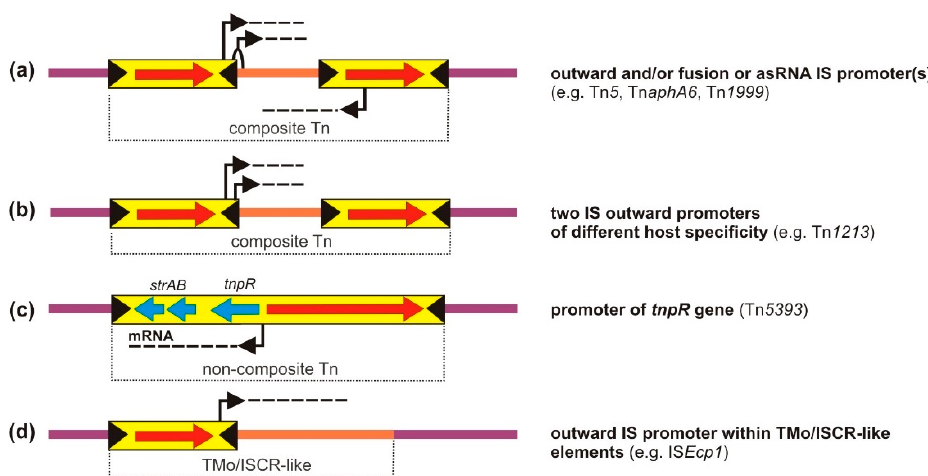
Figure 5. Promoters enabling or modulating the expression of AR genes transferred within Tns: ( a , b ) fusion and outward IS promoters within composite Tns; ( c ) internal promoters within non-composite Tns; ( d ) outward IS promoters within TMo/ISCR elements. See text for details. Symbols are identical to those used in Figure 2.